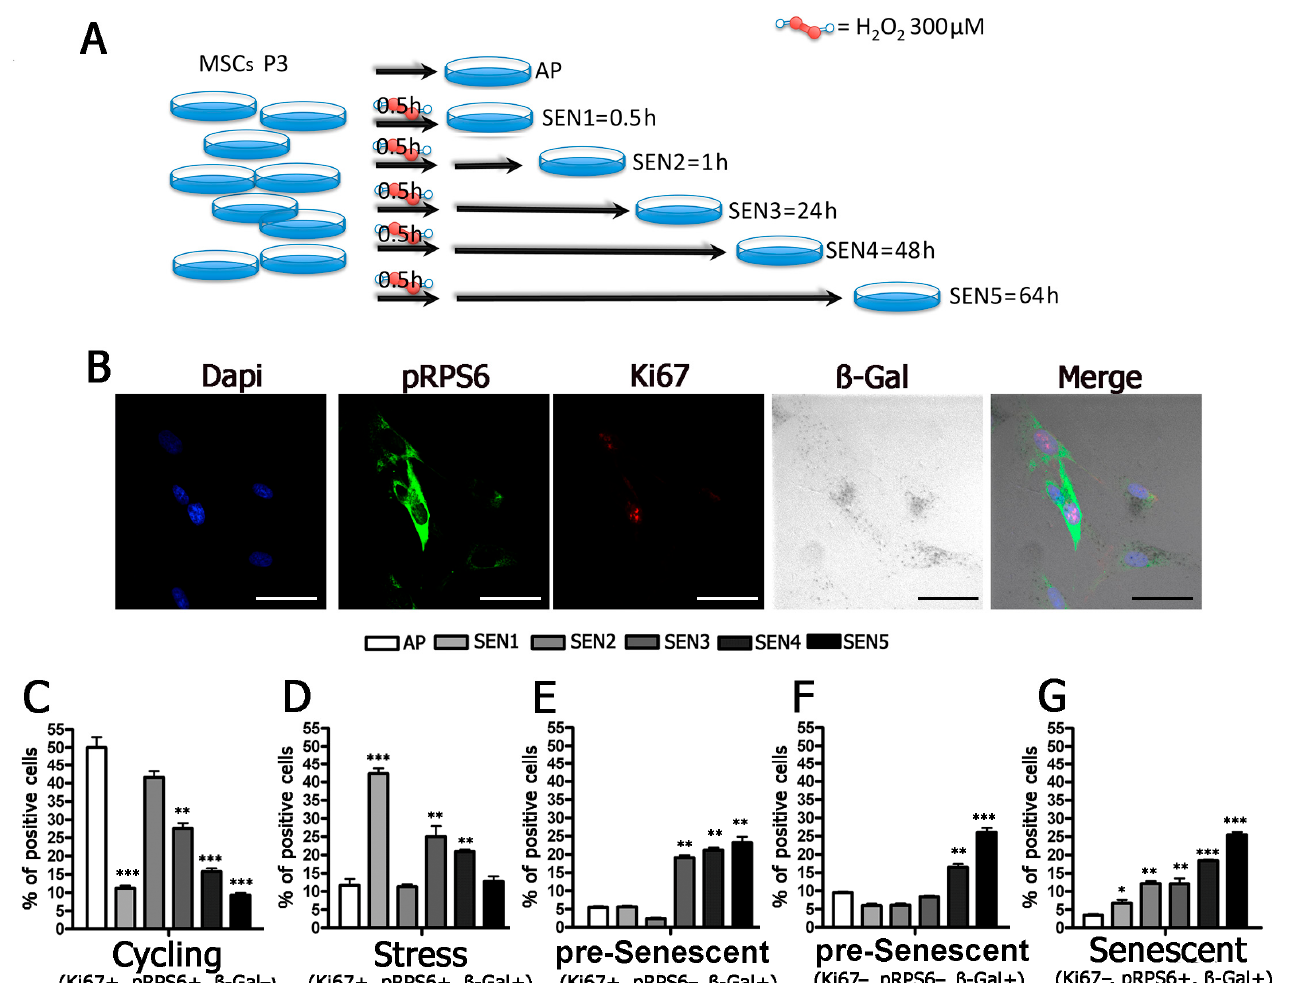
Figure 3. Molecular characterization of stressed and senescent cells. Panel ( A ): Graphic summary of experimental procedure. MSCs at passage 3 (P3) were treated for 0.5 h with H 2 O 2 and then incubated in cell culture medium for 64 h. At different time points (AP, SEN1, SEN2, SEN3, SEN4, SEN5), cell samples were collected for analysis. Panel ( B ): Representative micrographs of MSCs stained to identify nuclei (DAPI), pRPS6, and Ki67 and to evaluate SA- β -gal activity. The scale bar correspond to 100 microns. See also Supplemental File S3. Panels ( C – G ): Graphs show the percentage of cycling, stressed, pre-senescent and senescent cells at different time points (AP, SEN1, SEN2, SEN3, SEN4, SEN5). Below each graph, the molecular algorithm we used to identify the different phenotypes is indicated. In each graph, the * indicates the statistical difference between AP, chosen as the reference, and the other time points (* p < 0.05, ** p < 0.01, *** p < 0.001).